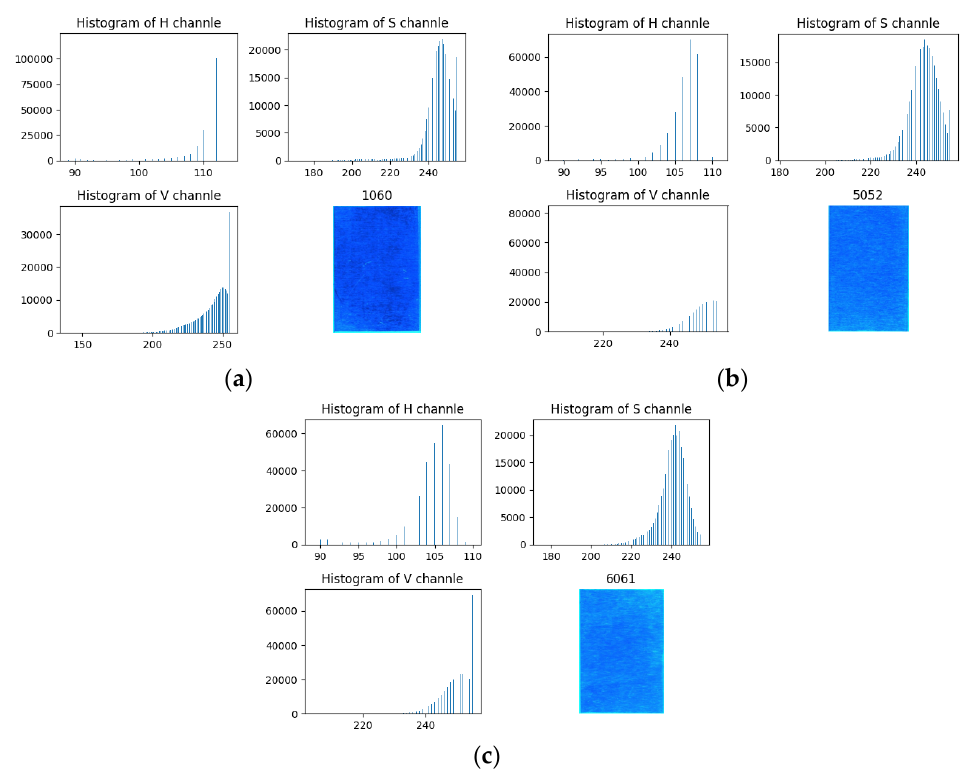
Figure 12. HSV color channel histogram, ( a ) 1060, ( b ) 5052, ( c ) 6061. The parameters of color in HSV are Hue (H), Saturation (S), and Value (V). As can be seen from the HSV chart, the images of 1060 differed from those of 5052 and 6061, and 5052 and 6061 looked slightly different.